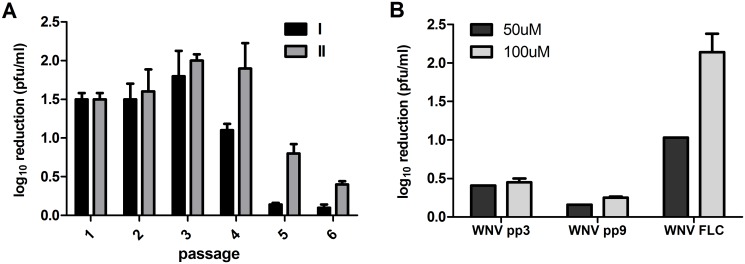
Selection for West Nile virus populations with decreased susceptibility to ribavirin.
A. Ribavirin susceptibility, measured as mean log10 pfu/ml reduction in viral titer +/- SD resulting from 50uM ribavirin treatment for 72h on Hela cell culture relative to untreated controls, following passage of parallel series of ribavirin-treated WNV-IC designated as lineage I (black) and lineage II (grey). B. Ribavirin susceptibility in selected clonal populations. Clonal populations were created with lineage I from 20 plaques isolations (pp) and strains with the highest levels of resistance (WNV pp3/9) were chosen for further characterization.